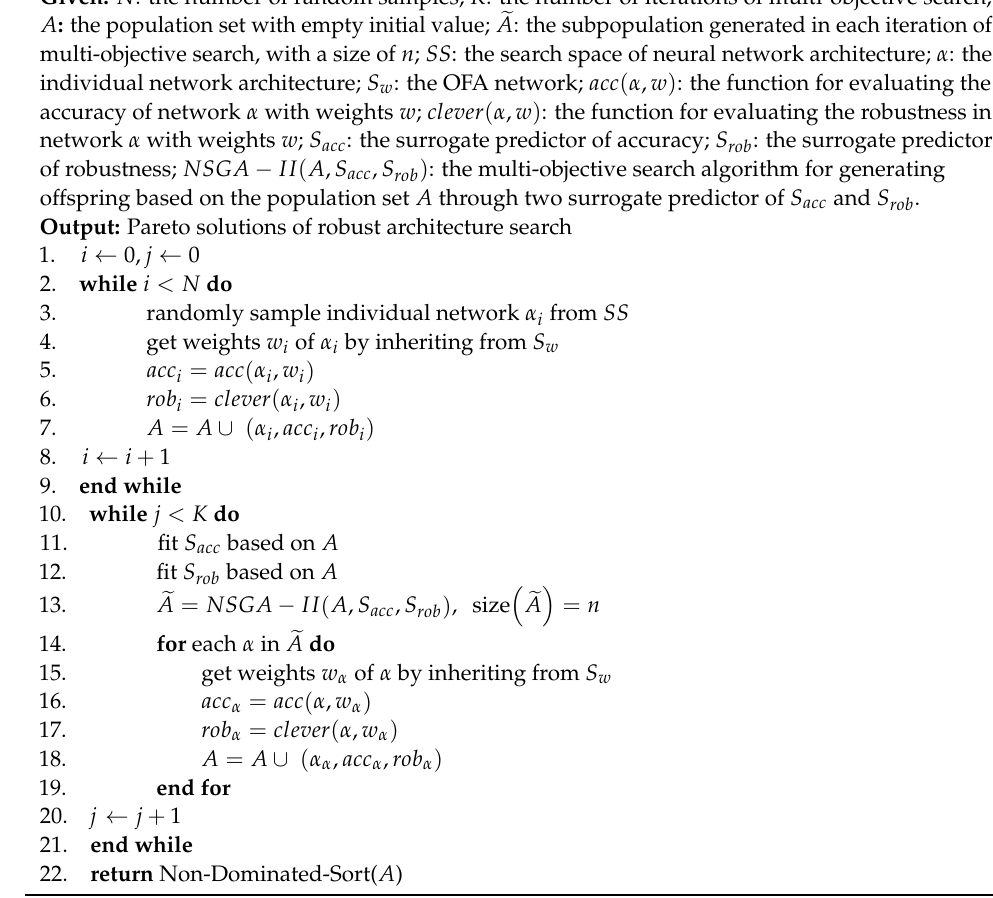
Algorithm 1. Robust architecture search